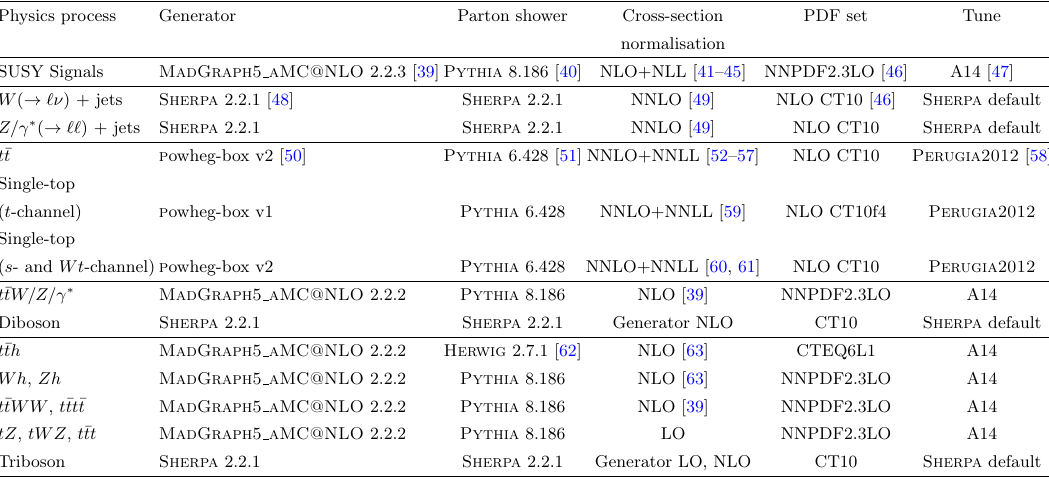
Table 1. Simulated signal and background event samples: the corresponding event generator, the parton shower, the cross-section normalisation, the PDF set and the underlying-event tune are